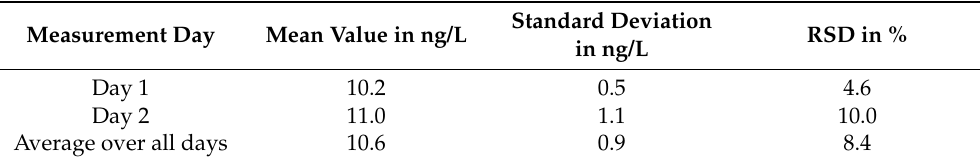
Table 2. Mean values, standard deviations, and relative standard deviations (RSD) as calculated from the voltammetric investigation of six independent Milli-Q water samples (three per day) each spiked with 10.0ng/L platinum as measured by